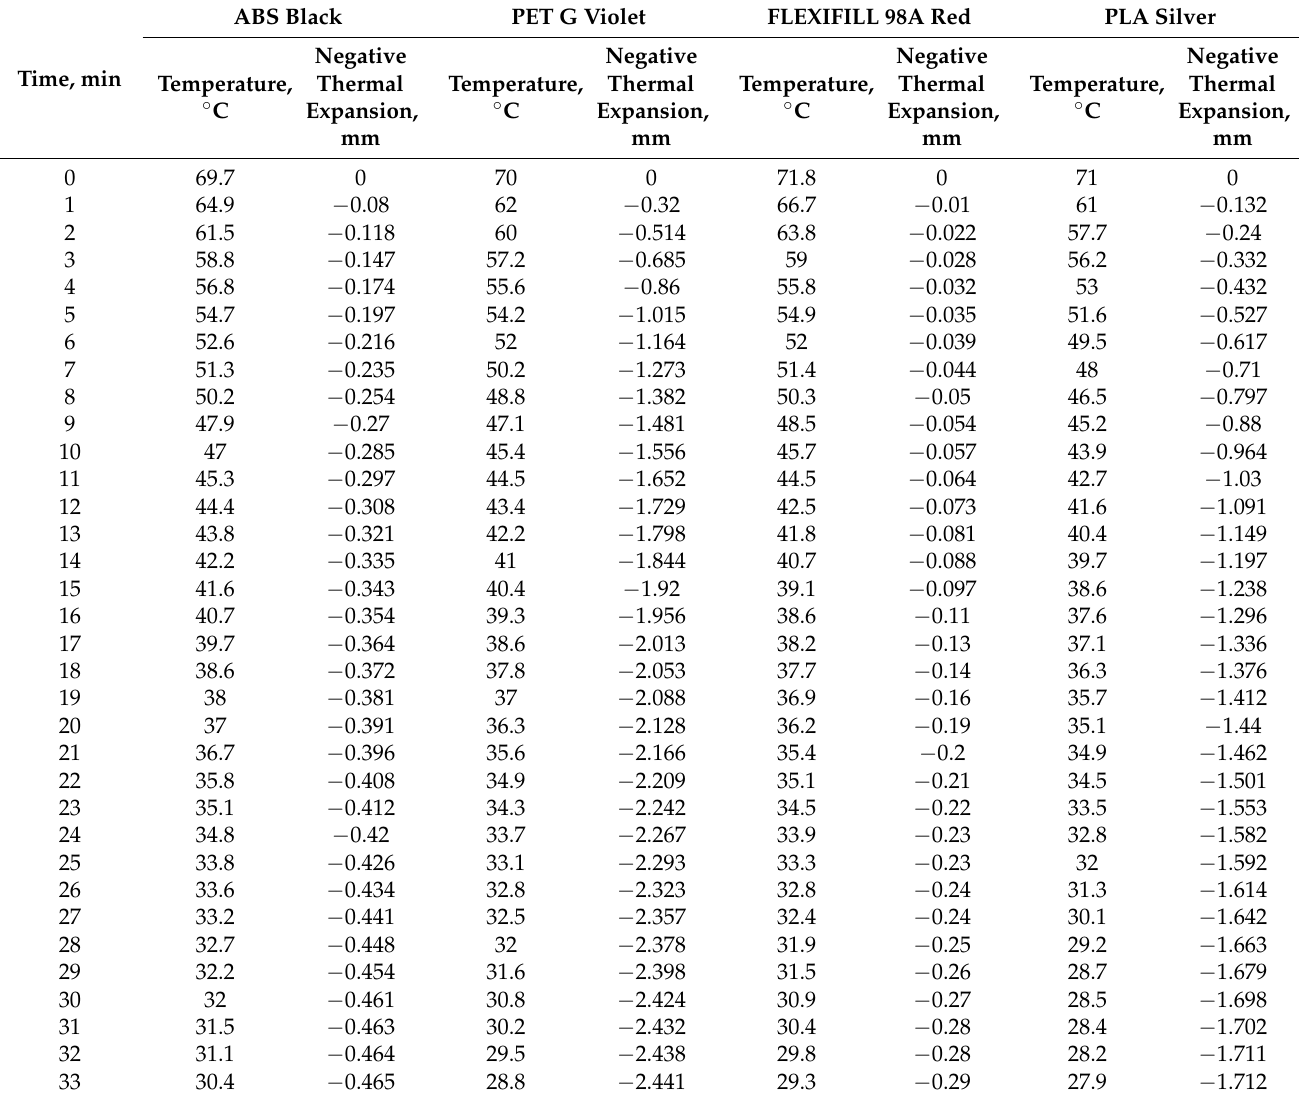
Table 3. Experimental results regarding the negative thermal expansion of some polymeric